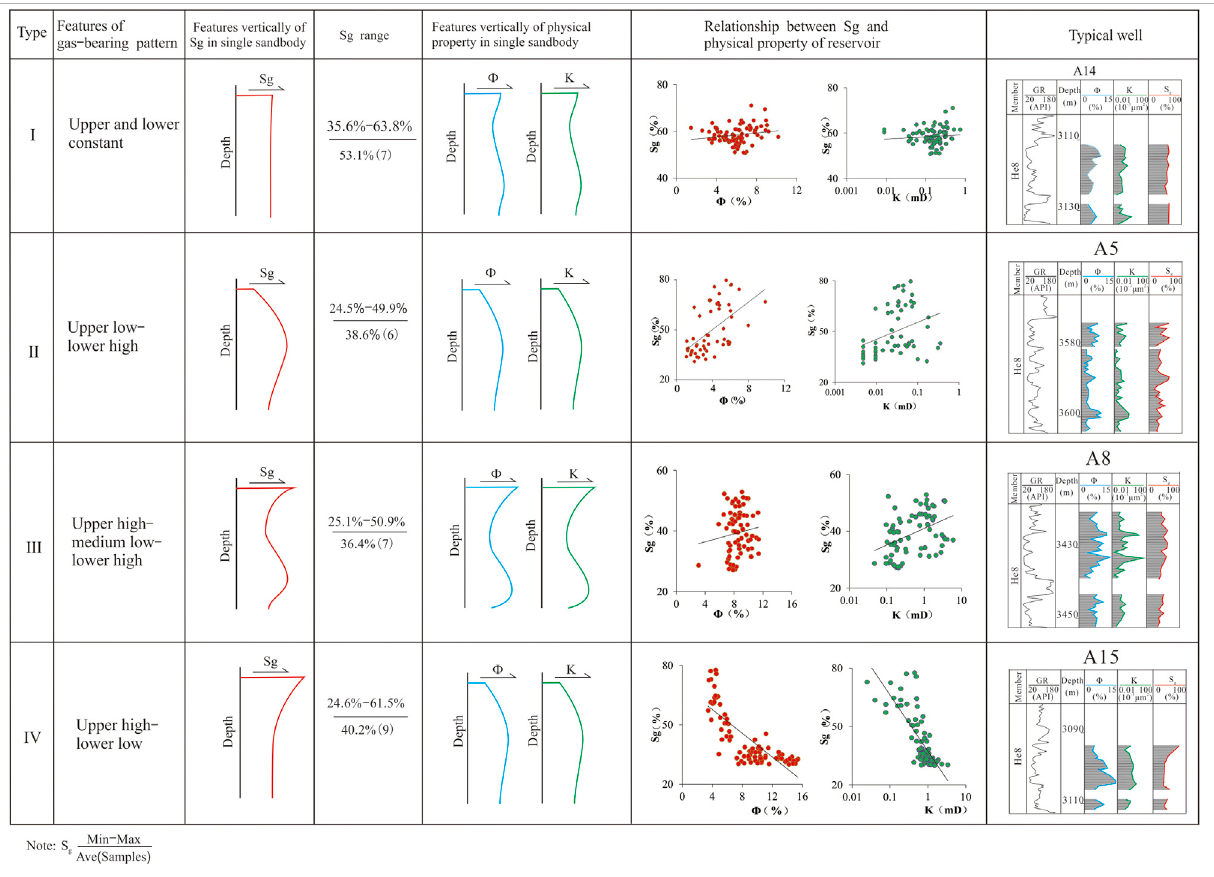
TABLE 1 | Gas-bearing distribution patterns of tight sandstone of He8 Member in